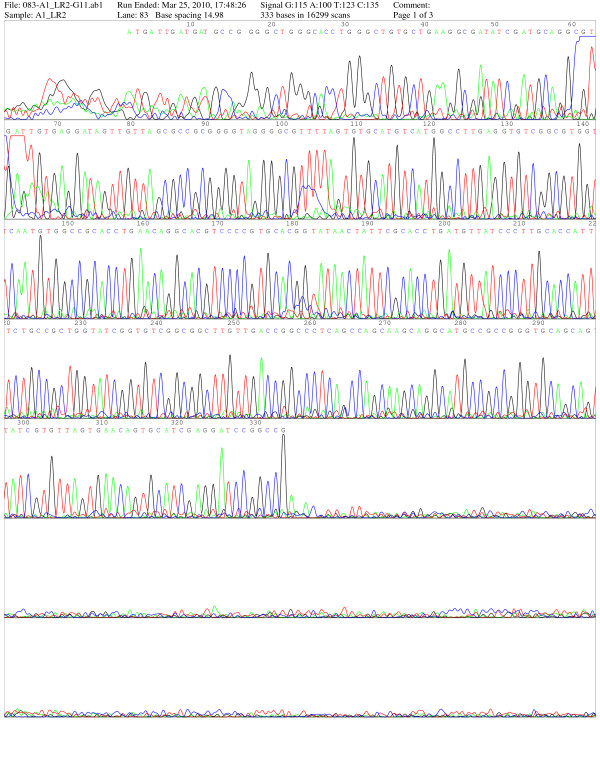
Sequencing report.